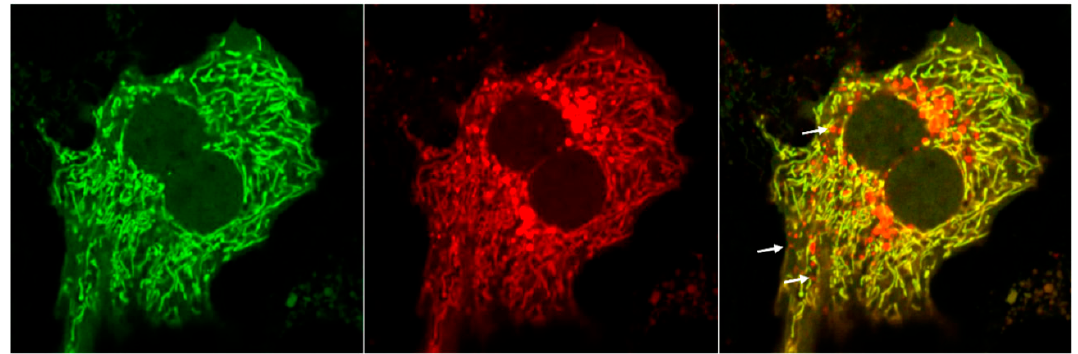
Figure 3. Monitoring mitophagy in primary hepatocytes using Cox8-GFP-mCherry. Primary mouse hepatocytes were infected with adenovirus-Cox8-GFP-mCherry (10 MOI) for 72 h followed by confocal microscopy. Arrows denote red-only autolysosome-enwrapped mitochondria.